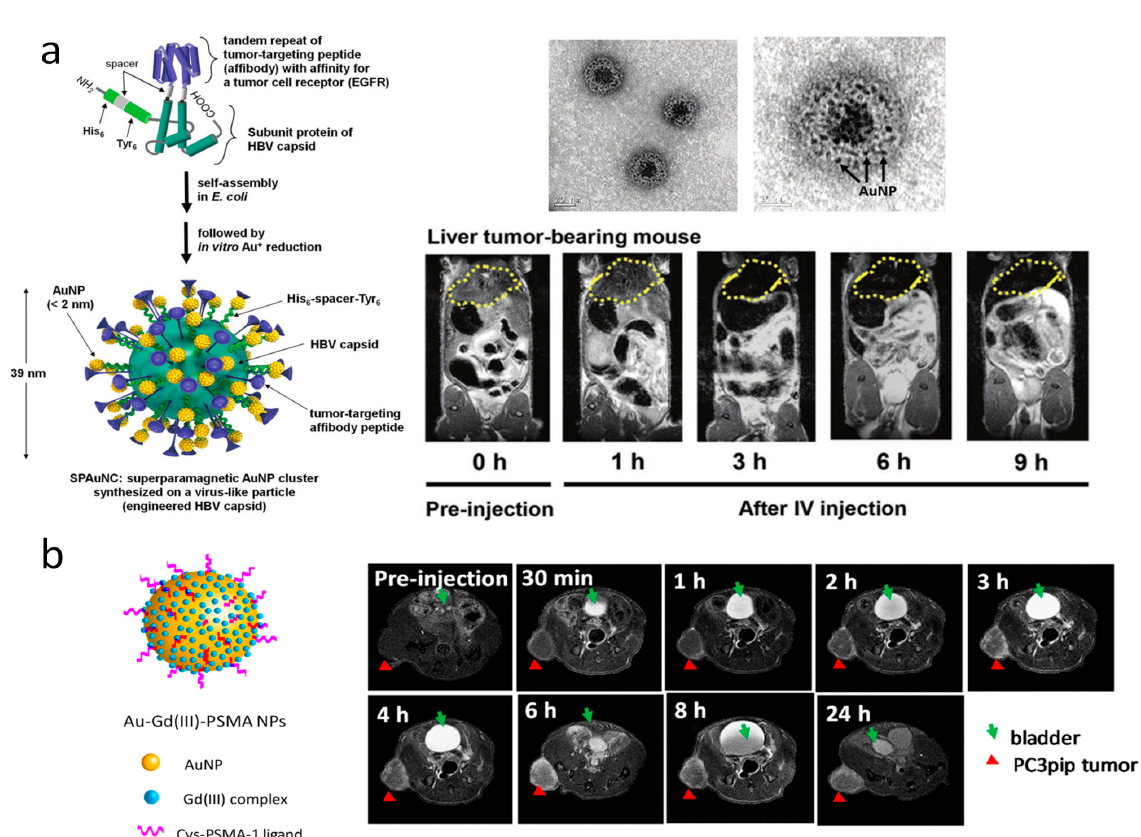
Figure 1. ( a ) Schematics of an SPAuNC and its synthetic procedure (left) and transmission electron microscopy (TEM) analysis of SPAuNCs (top right); T 2 -weighted MR images of liver tumor (MDA-MB-468) bearing mice showing the time course of after SPAuNCs injection (down right, liver as indicated by yellow dots). Adapted with permission from Wiley [62]. ( b ) Schematic representation of Au − Gd(III)- prostate-specific membrane antigen (PSMA) nanoparticles (NPs) and time course in vivo T 1 -weighted spin echo images of mice showing active targeting of NPs to PC3pip tumor (red triangles). Adapted with permission from American Chemical Society